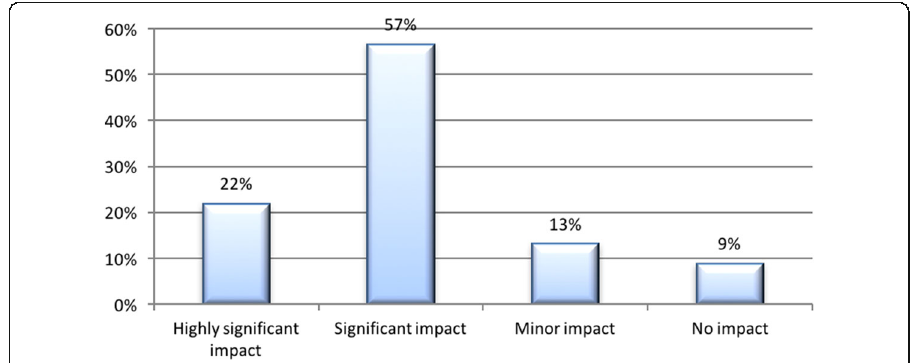
Fig. 7 Student perceptions of their learning of concepts through discussion board conversations